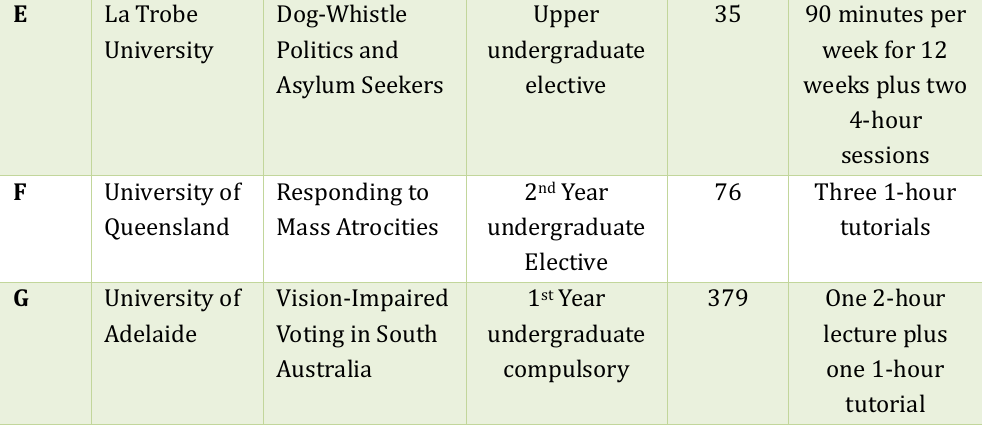
Table 1: Case Studies at a glance a) Peacemakers and warriors: Self-determination in West Papua, Indonesia